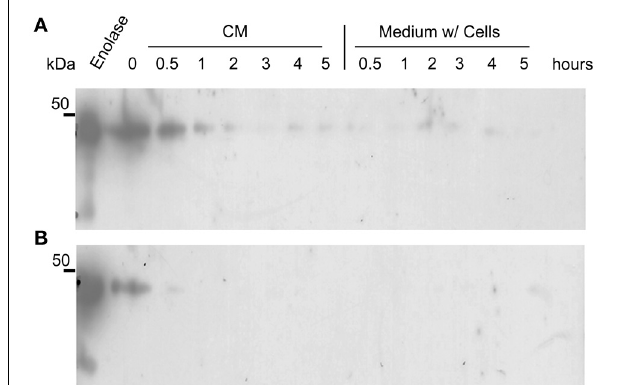
FIGURE 4 | Western blots of the kinetics of C. albicans SC5314 enolase decay in conditioned media. Aliquots of 5ml conditioned minimal medium (CM) only and stationary cultures (w/ = with cells) were maintained at room temperature (A) and at 37 ◦ C (B) , without agitation. Samples were removed and analyzed by western blot (Probed with anti His 6 -enolase). Numbers indicate the time interval of sampling in hours.